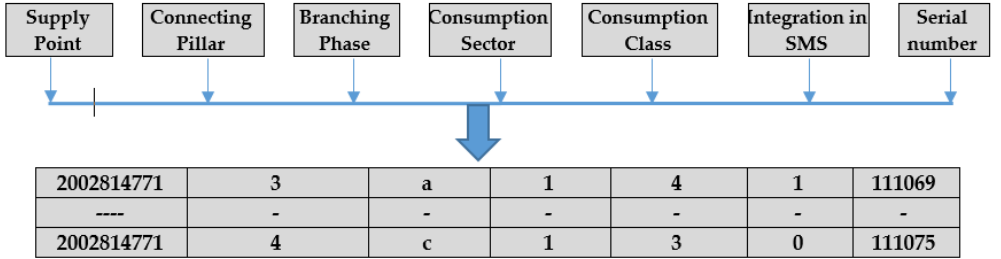
Figure 4. The input data sequence of the algorithm.